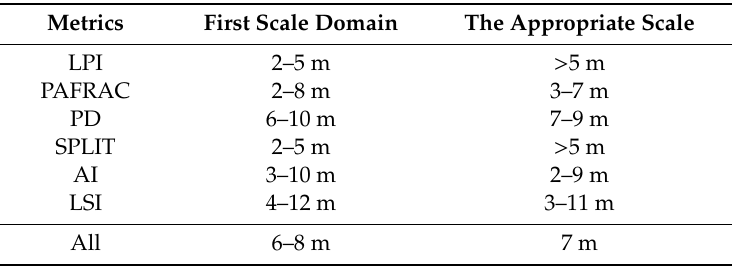
Figure 8. Response curve of landscape indices. Table 2. The appropriate scale of the landscape